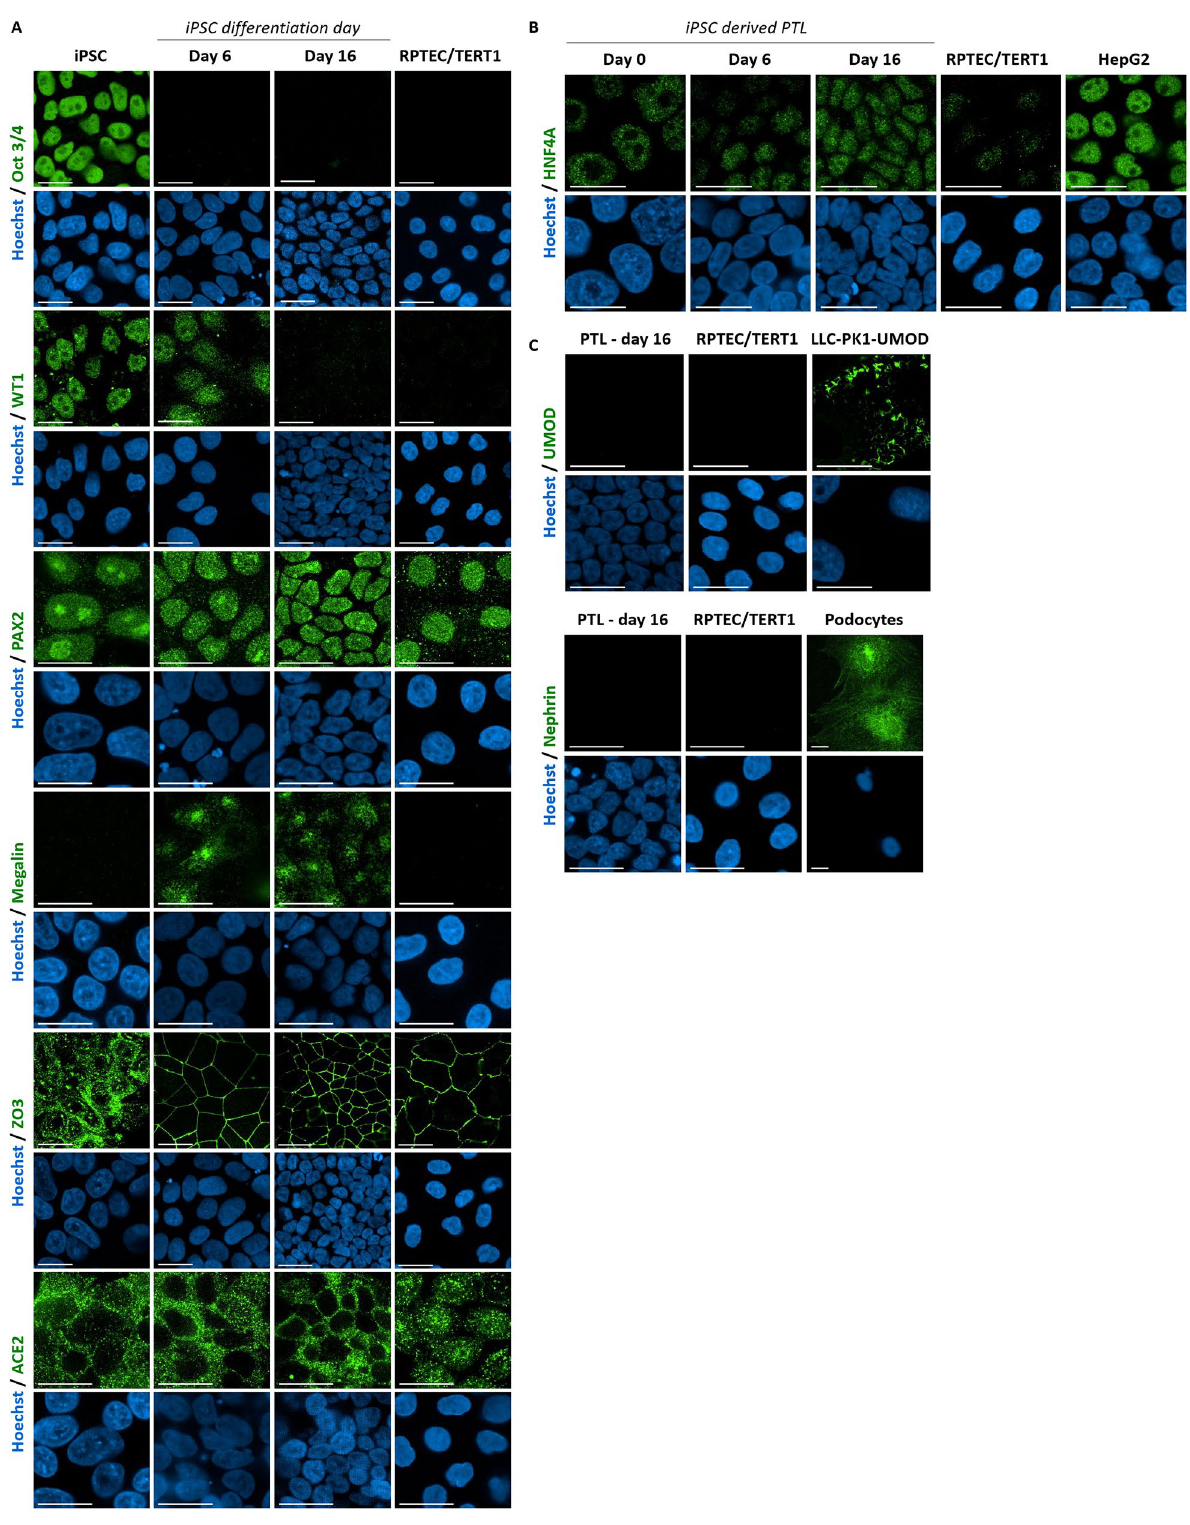
Figure 3. Immunofluorescence imaging of PTL and control cell lines. iPSC (SBAD2) were differentiated on Geltrex in 96 well pates as indicated and fixed at day 0, day 6 and day 16. Indicated immune targets are given in green and Hoechst staining is shown in blue ( A ). Images were captured using confocal microscopy with 40 × or 63 × water objectives. All exposure settings were the same. The scale bar represents 20 µm. HepG2, human uromodulin expressing (transgenic) LLC-PK1 cells and iPSC derived podocytes were used as positive controls for HNF4A ( B ), uromodulin and nephrin ( C ) respectively. The images are scaled post acquisition to the positive control. (The podocyte image is